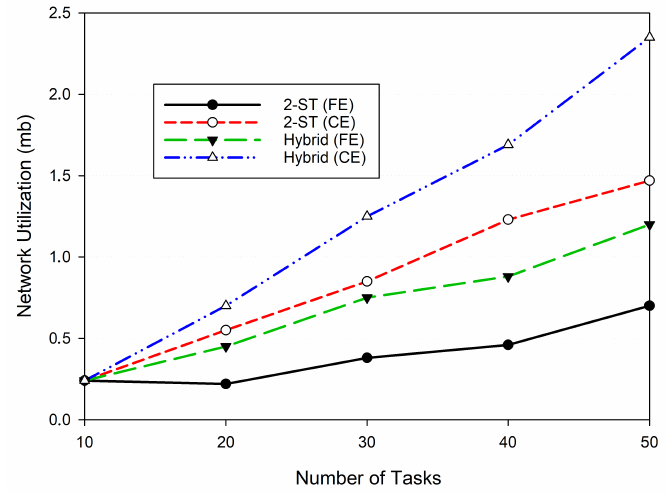
Figure 7. Network utilization of both the cloud and fog environment using the 2-ST and hybrid approaches for task